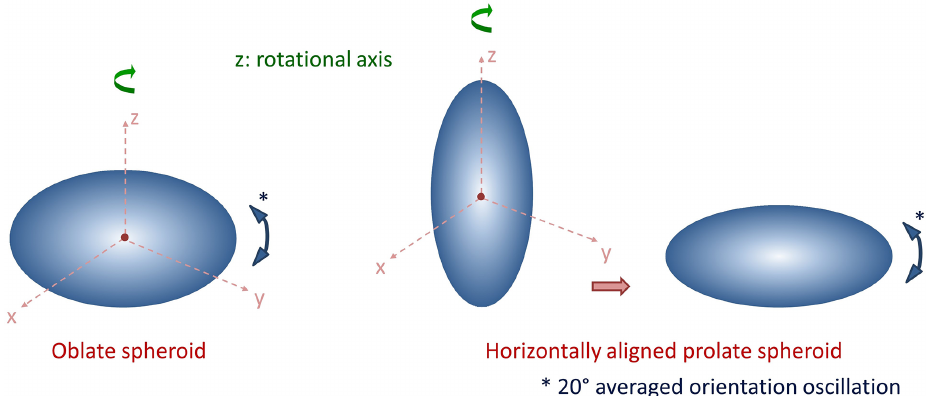
Figure 6. Description of simulated oblate, vertically aligned prolate, and horizontally aligned (rotated 90 ◦ in the y – z plane) prolate ice spheroids. Only oblate and horizontally aligned prolate ice spheroids were used in the scattering simulations with a 20 ◦ standard deviation out of the horizontal plane.